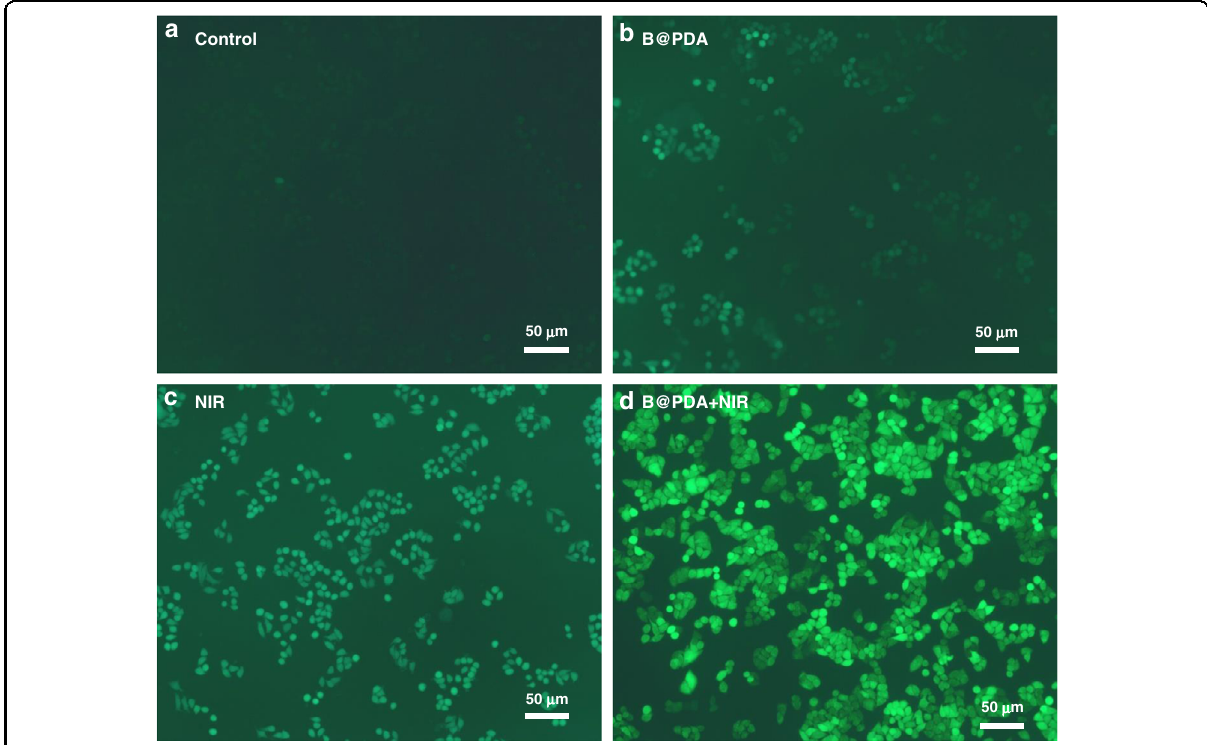
Fig. 7 ROS measurement. a Control. b The HCT-116 cells were treated with B@PDA. c The HCT-116 cells were exposed to 808 nm irradiation (10 min, 1 W cm − 2 ). d HCT-116 cells were cultured with B@PDA, and the cells were then irradiated with 808 nm (10 min, 1 W cm − 2